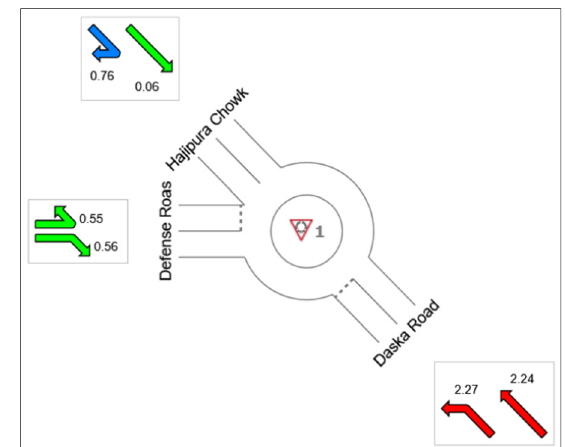
Fig. 5: Degree of Saturation of Existing Condition at Daska Intersection